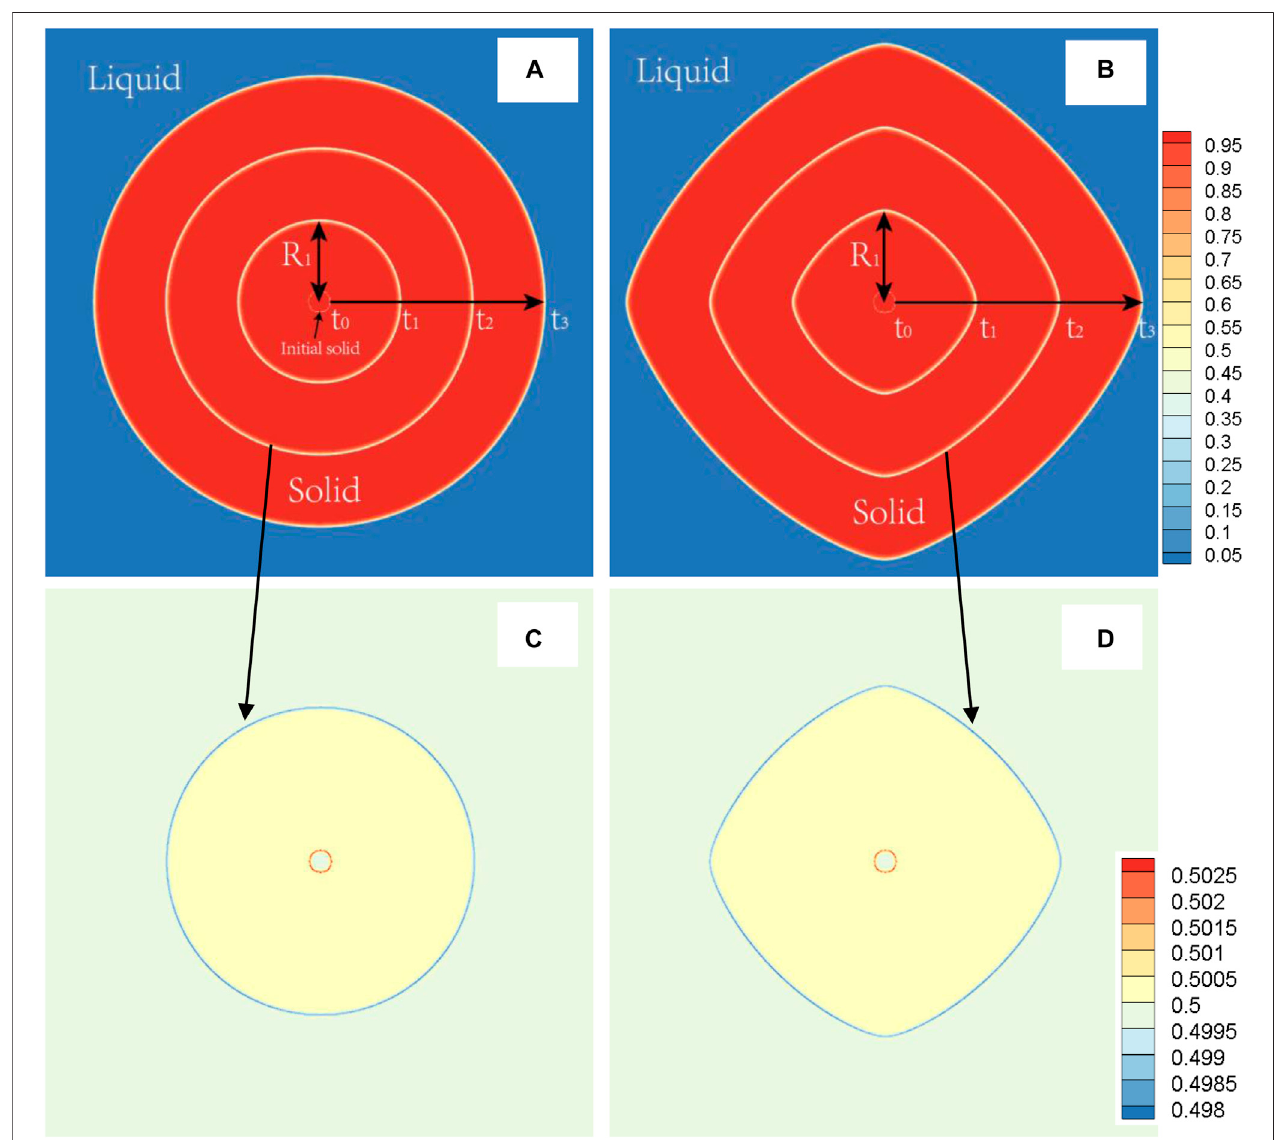
FIGURE 5 | (color online) During the solidi fi cation process at 1800 K (TDB1), the solid phase morphology superimposed images at different times ( t 0 (cid:3) 0, t 1 (cid:3) 300, t 2 (cid:3) 600, t 3 (cid:3) 900) (A) δ (cid:3) 0.0 (B) δ (cid:3) 0.06, and representative image of the concentration fi eld at the time of t 3 , (C) δ (cid:3) 0.0, (D) δ (cid:3) 0.06. R 1 displays the de fi nition of main radius at the time of